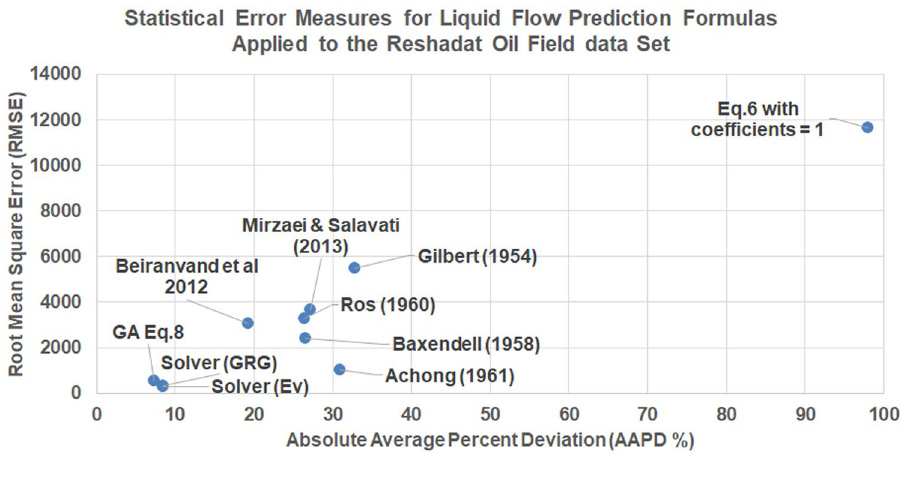
Fig. 12 A comparison between root-mean-square error (RMSE, Eq. 16) and absolute average percent deviation (AAPD%, Eq. 13) for the Reshadat oil field for the various flow-rate prediction methods identified in Fig.